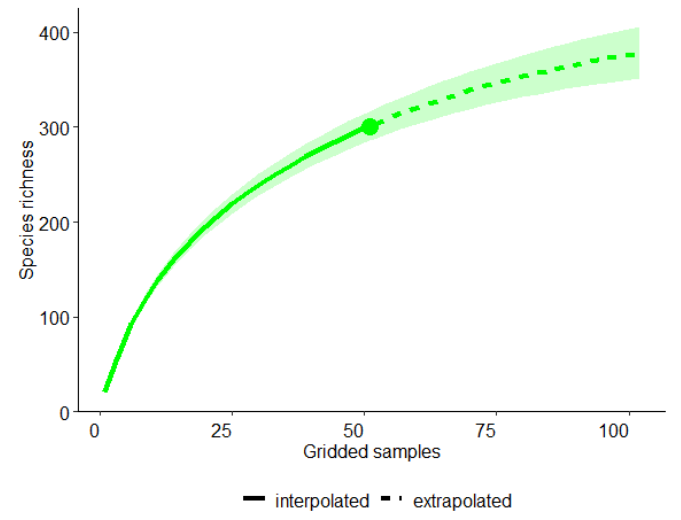
Figure 3. A sample-based interpolation and extrapolation curve of geometrid moths collected from Mongolia with 0.95 confidence interval. 51 grids were sampled with altogether 301 species. Axes X and Y represent the number of gridded samples and species richness,